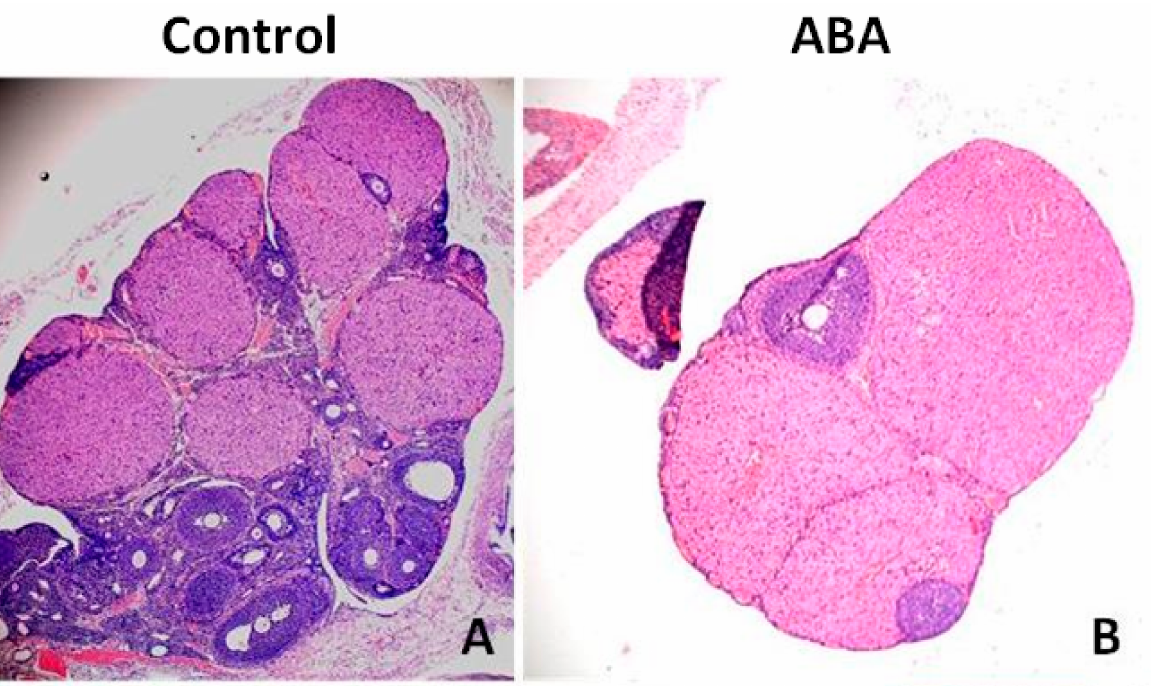
Figure 8. Ovarian tissue from the control group ( A , C ) and ABA ( B , D ) group stained for Inhibin B (green, Alexa Fluor 488). Preantral follicles are positive for the current marker, while pre-dominant and dominant follicles are negative for Inhibin B. Total magnification: × 200 ( A , C ); × 400 ( B , D ).